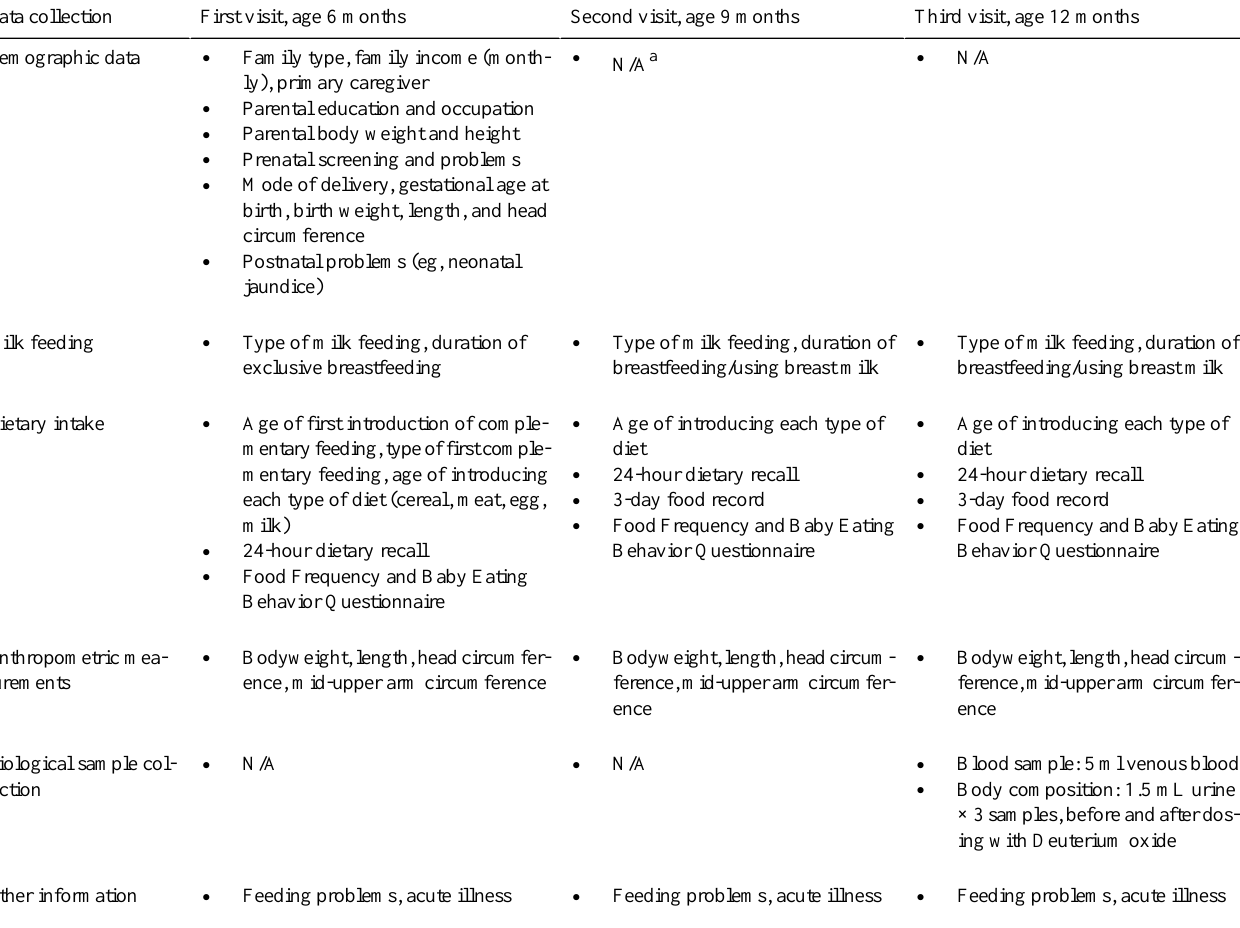
Table 1. Data and collection of biological samples.